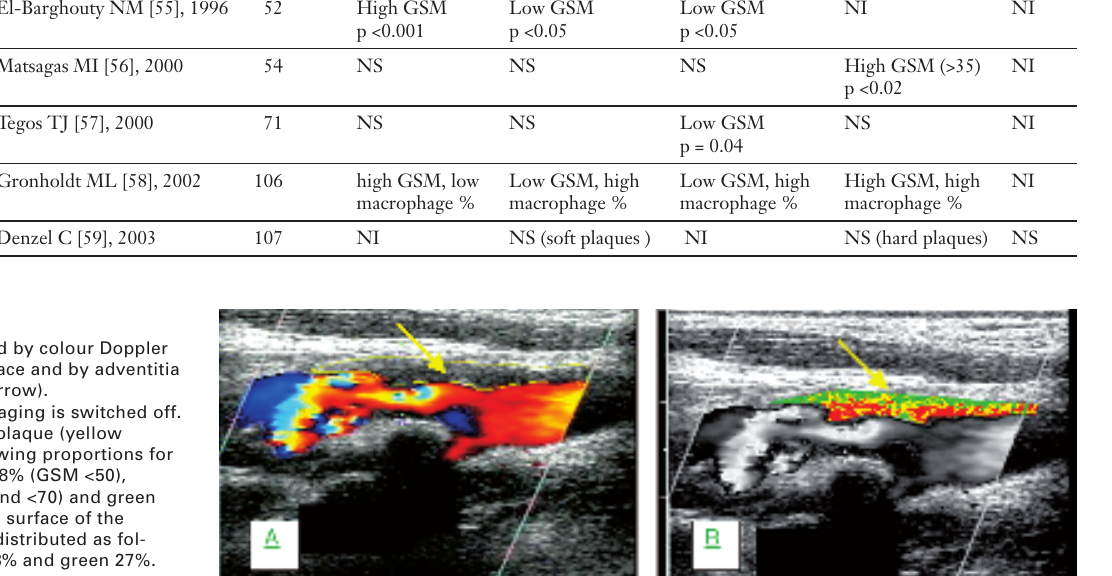
Correlation between computerised analysis (GSM) of carotid plaque and histopathological